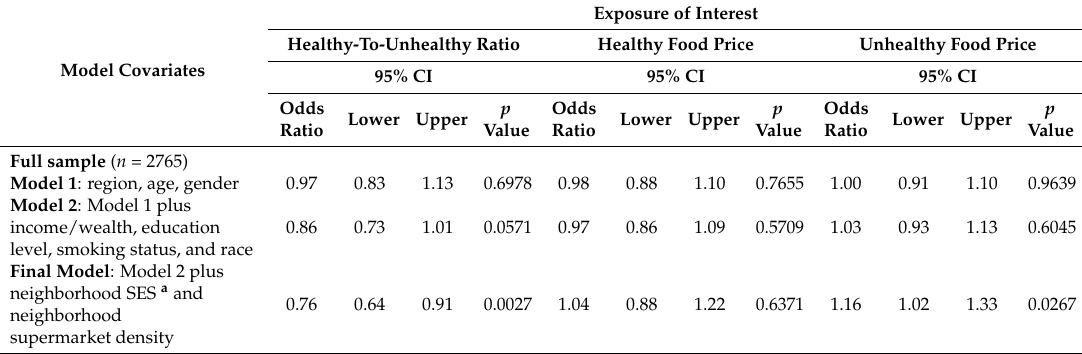
Table 3. Odds ratios of having a high-quality diet associated with the price ratio, and with the prices of healthy foods and unhealthy foods after sequential adjustment for confounders within the full population ( n =